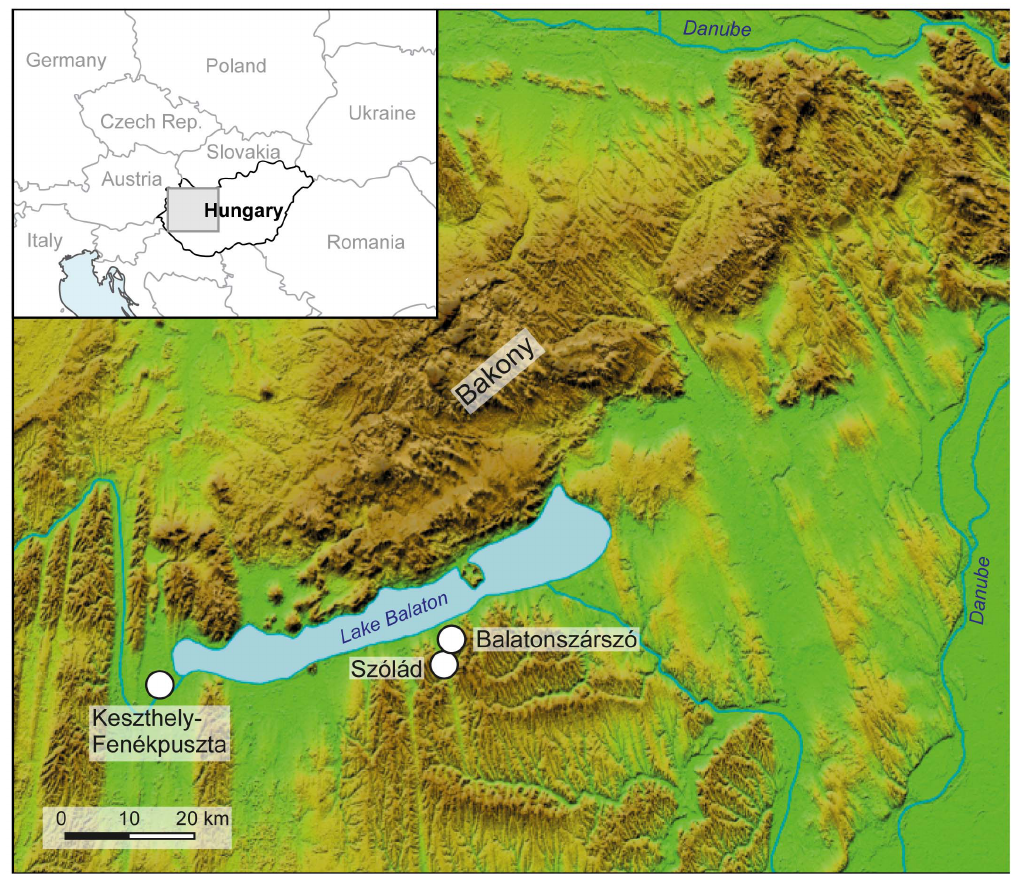
Figure 1. Map showing the location of the Szo´la´d cemetery on the southern shore of Lake Balaton and the sites of Balatonsza´rszo´ and Kestzthely-Fene´kpuszta, which have yielded strontium isotope reference data. The DEM is based on SRTM (90 m) data, edited by H.-J. Ko¨hler, U. v. Freeden, D. Peters and C. Knipper.